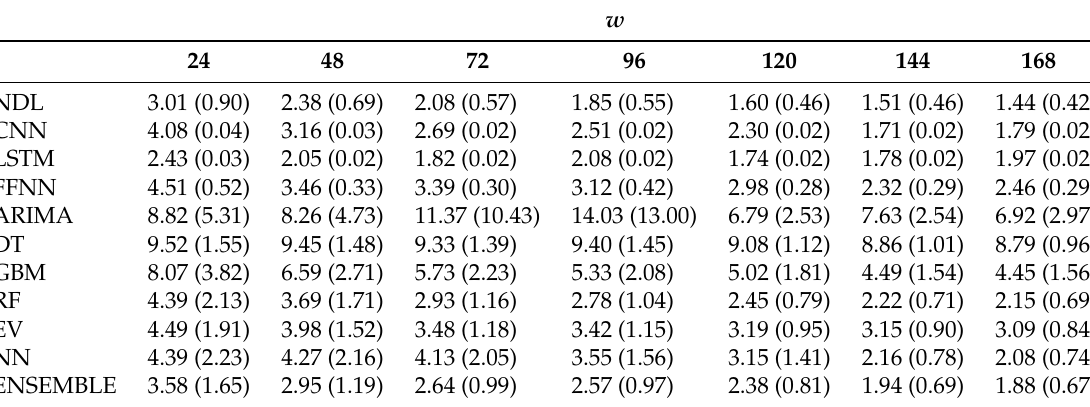
Table 5. Average results obtained by different methods for different historical window values. Standard deviation between